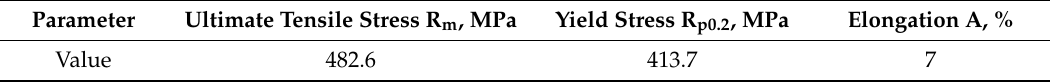
Table 1. The basic mechanical properties of Alclad 7075-T6 aluminum